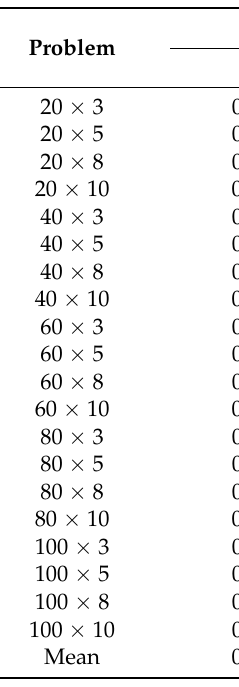
Table 10. C -metric for SDABC and